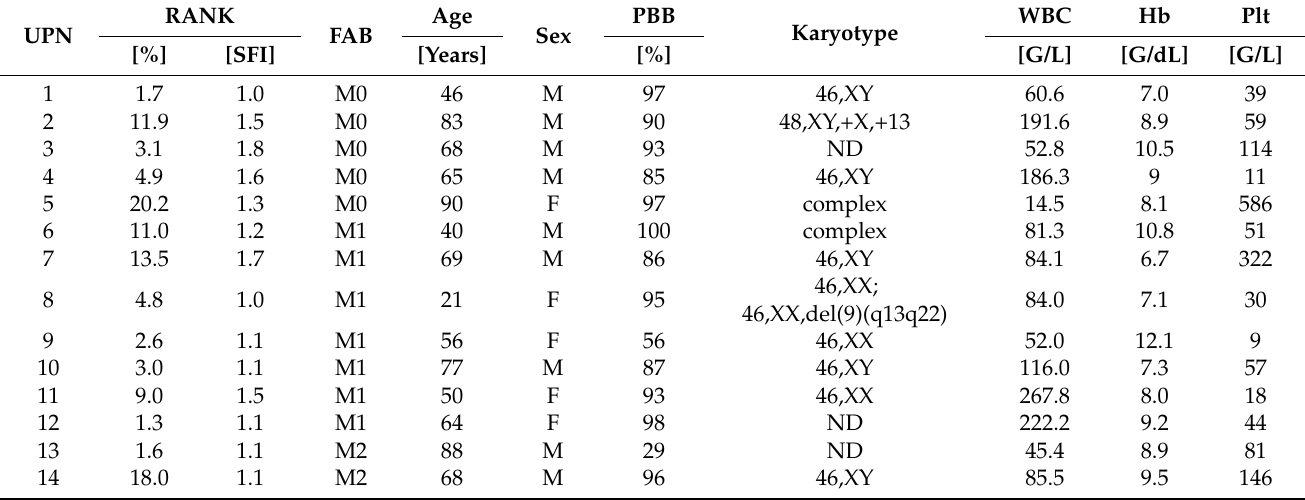
Table 1. Patient characteristics and RANK